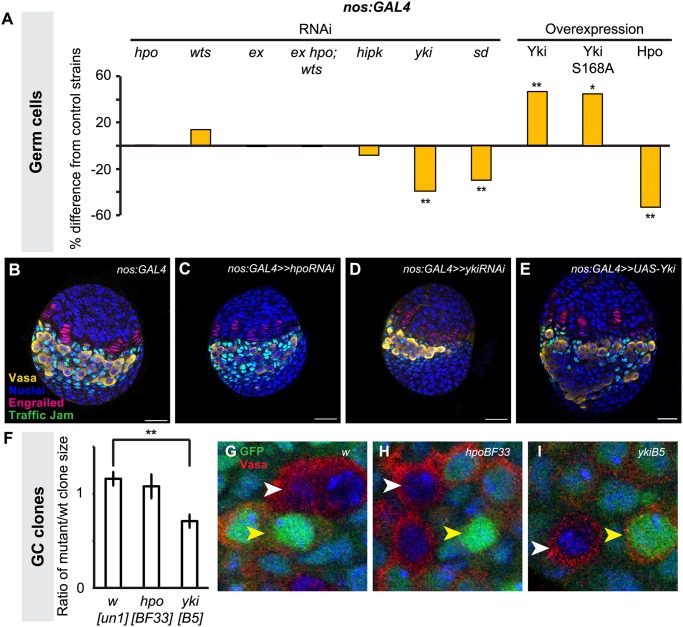
Yorkie activity regulates GC number.Changes in (A) GC number in ovaries expressing hpo, wts, ex, hpo/wts/ex triple, hipk, yki or sd RNAi, or overexpressing hpo, yki or yki
S168A under the nos:GAL4 driver. Bar graphs are as explained in Fig. 2 legend. * p<0.05, ** p<0.01 against controls. n = 10 for each genotype. Numerical values can be found in S2 Table. (B–E) LP stage larval ovaries representative of control and experimental samples used to obtain cell type counts. Scale bar = 10 μm. (F) Ratio of size (number of cells per clone) of homozygous mutant versus homozygous wild type twin spot clones for control (w
un-1), hpo
BF33 and yki
B5 alleles. ** p<0.01 against control. (G–I) LP stage larval ovaries representative of control and experimental samples for clonal analysis showing GCs (Vasa, red), homozygous wild type clones (strong GFP expression; yellow arrowhead), and clones homozygous for tested alleles (no GFP; white arrowhead). n = 10 for each genotype.